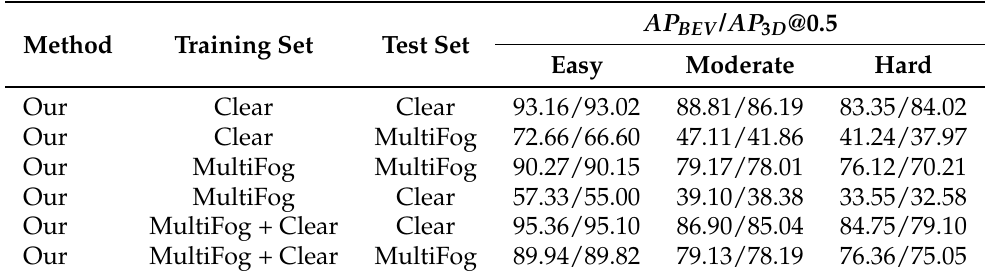
Table 1. AP BEV / AP 3 D results with training and testing on the Clear KITTI or Multifog KITTI datasets for “Car” objects with IoU = 0.5 on three levels of difficulty: Easy, Moderate and Hard.